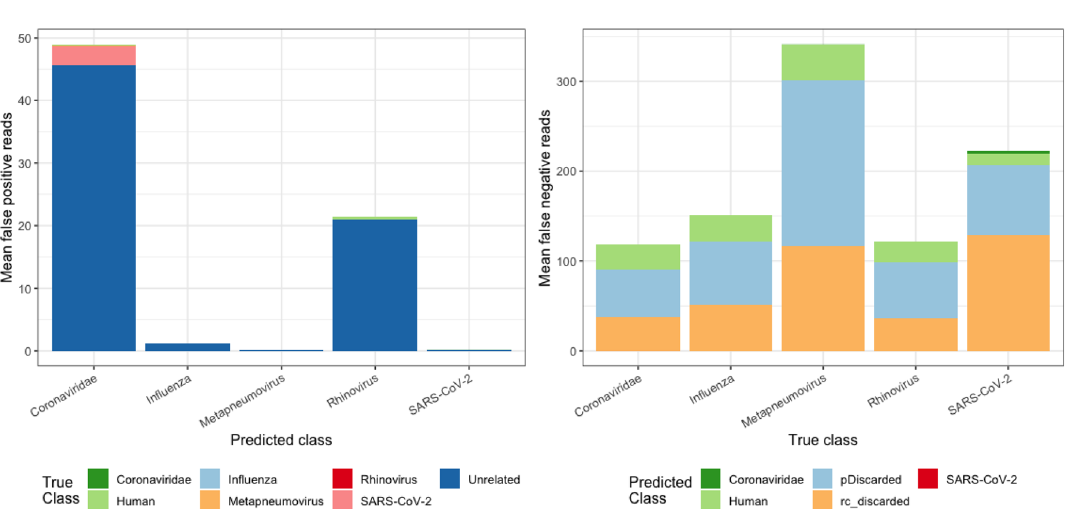
Figure 4. False positive and false negative assignments for 100 independently simulated datasets. Left panel— Average number of false positives (y axis). True labels are indicated by colour for each class and predicted labels are given in the x-axis. Right panel—Average number of false negatives (y axis). Predicted labels are indicated by colour for each class and true labels as indicated in the x-axis. pDiscarded—reads that do not reach the 0.95 posterior probability cut-off; rc_discarded—reads that were discordantly predicted using double prediction